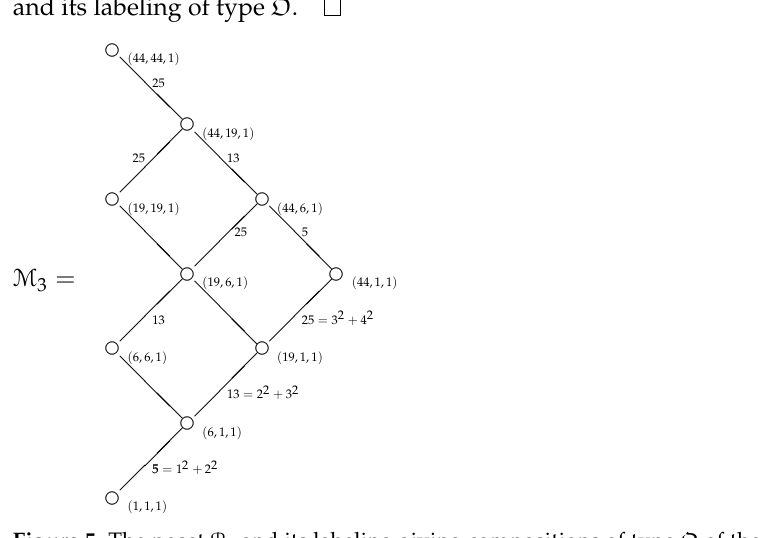
Figure 5. The poset P 3 and its labeling giving compositions of type O of the number